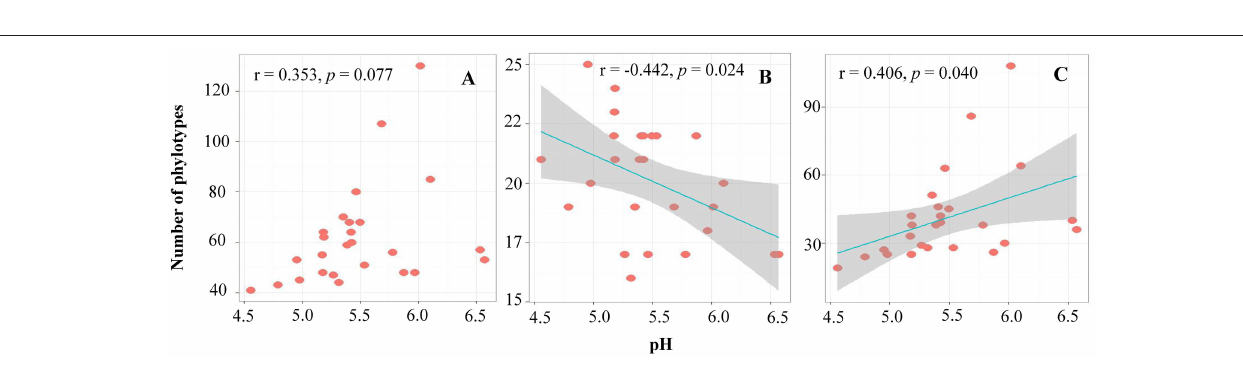
archaea in the agricultural soils varied between studies.